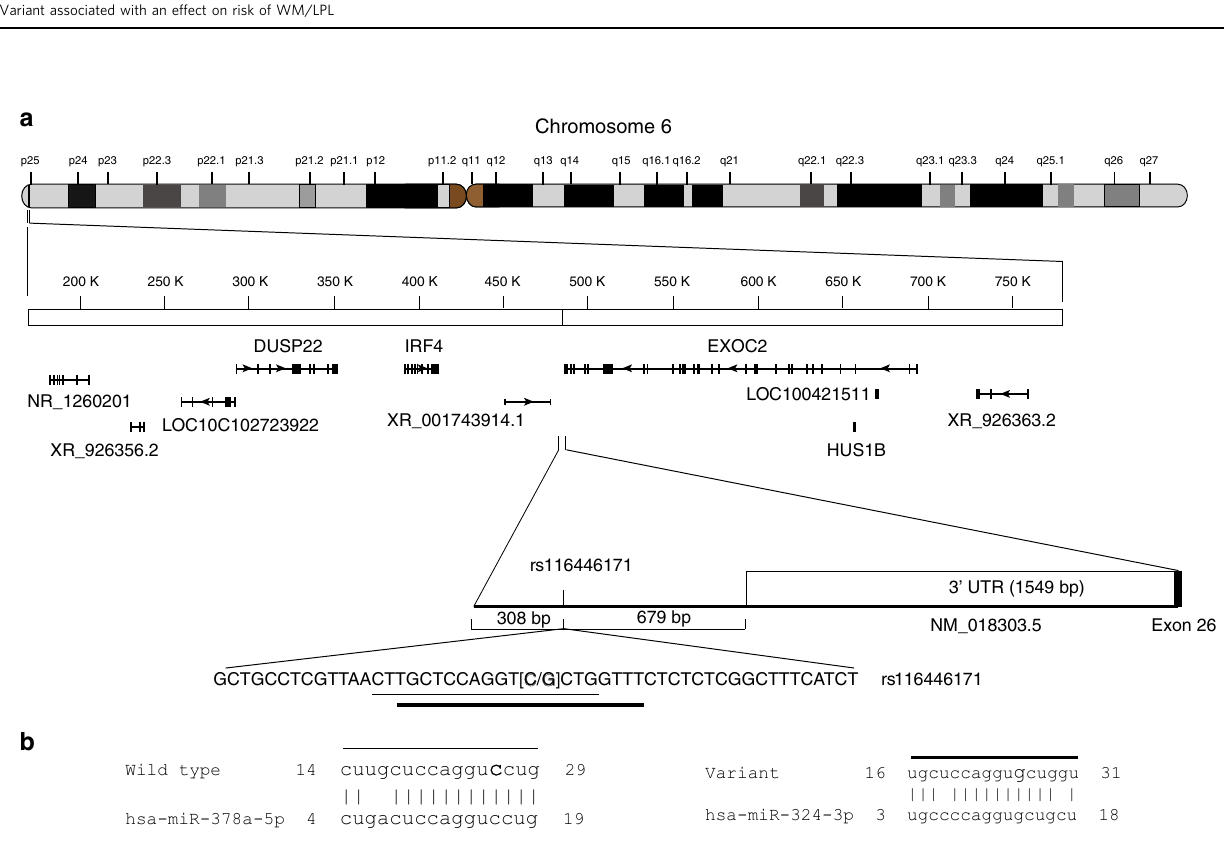
Fig. 2 Genomic position and alignments of rs116446171 to miRs. a Schematic representation of the position of rs116446171 relative to the 3 ′ UTR of EXOC2 on chromosome 6 and b alignments of rs116446171 wild type and risk variants with the binding sites of microRNAs, miR-378a-5p and